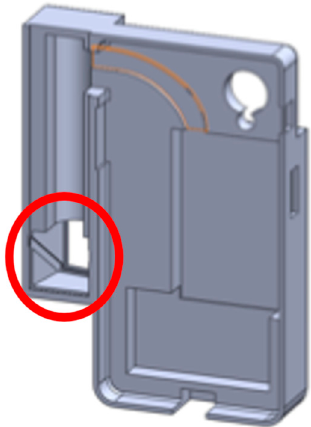
Figure 6. DDRS enclosure with the 2-dimensional angled mirror housing highlighted with a red circle.